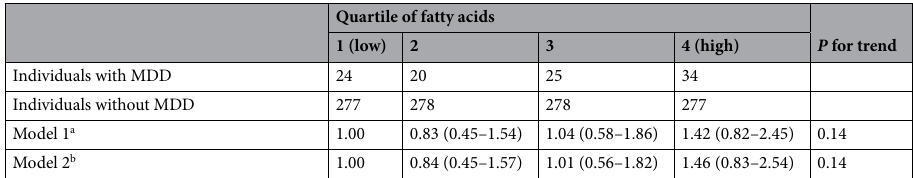
Table 3. Odds ratios and 95% confidence intervals for MDD according to quartile of plasma PUFAs in the JPHC Study (n = 1,213). Fatty acids are expressed as percentage of total fatty acid. Abbreviations: AA, arachidonic acid; DHA, docosahexaenoic acid; DPA, docosapentaenoic acid; EPA, eicosapentaenoic acid; MDD, major depressive disorder; PUFAs, polyunsaturated fatty acids. a Crude odds ratios. b Adjusted for age, sex, past history of depression, cancer, stroke, myocardial infarction, and diabetes mellitus. After individuals without MDD were categorized according to the quartile distributions of plasma phospholipid fatty acid level using the SAS program, boundary values were calculated by averaging the maximum and minimum values of lower and higher quartiles, respectively. For example, the first boundary value was calculated by averaging the maximum value of first quartile and minimum value of the second quartile. Although the original values (first, second and third boundaries) were computed to seven decimal places, the respective values shown are rounded to one or two decimal places: 9.8, 11.2, and 12.9 for total n-3 PUFAs; 0.29, 0.33, and 0.39 for α-linolenic acid (ALA); 1.93, 2.63, and 3.56 for EPA; 6.40, 7.22, and 7.99 for DHA; 0.82, 0.95, and 1.11 for DPA; 27.5, 29.4,